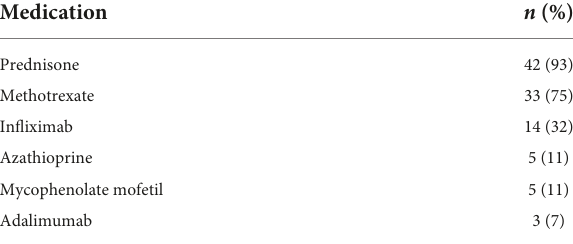
TABLE 2 Pharmacological treatment of patients with cardiac sarcoidosis ( N = 44).